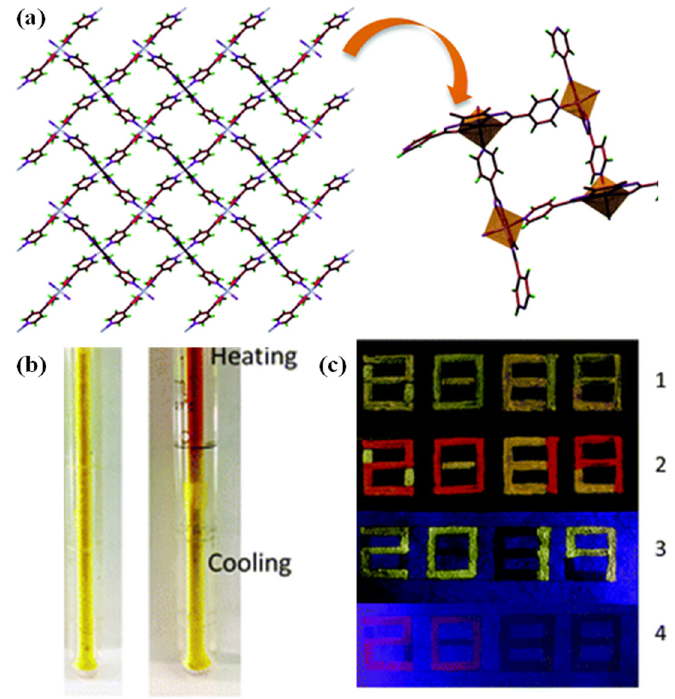
Figure 3. ( a ) 2D stick view of Zn (II) coordination polymer; zoom in view on the right with the Zn centers highlighted in brown polyhedral. ( b ) Photos of Zn (II) coordination color change upon temperature gradient. ( c ) Temperature dependent fluorescence color change for security application; (1) represents the compound at ambient temperatures (2) under 80 °C. A non-thermochromic compound showed temperature stabilization: (3) under UV irradiation and (4) under UV irradiation at 80 °C. Reprinted with permission from Ref. [29]. Copyright 2020, Royal Society of Chemis- try.